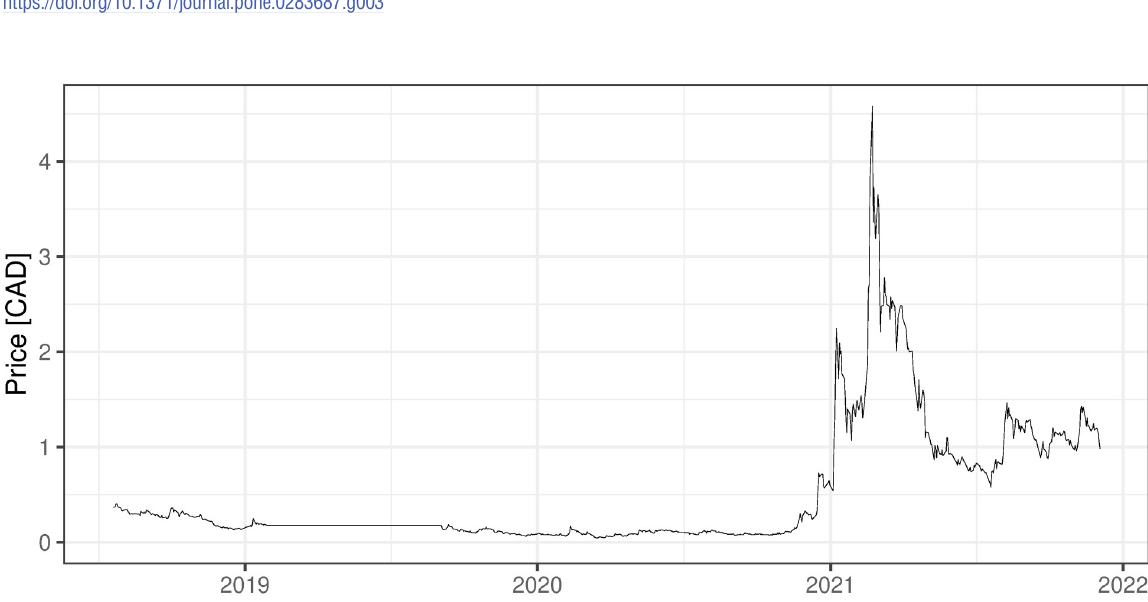
Fig 4. The daily fluctuations of DMG Blockchain prices on TSE. Source: https://finance.yahoo.com/quote/DMGI.V/history?p=DMGI.V (downloaded on 2021/12/03).